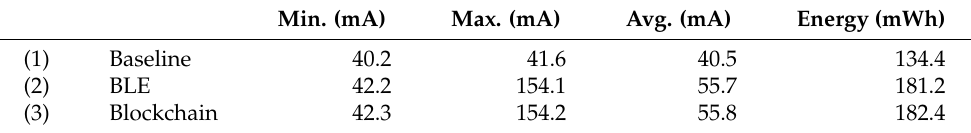
Table 6. Power requirements and energy consumption (at 3.3 V) in 30 s windows for three